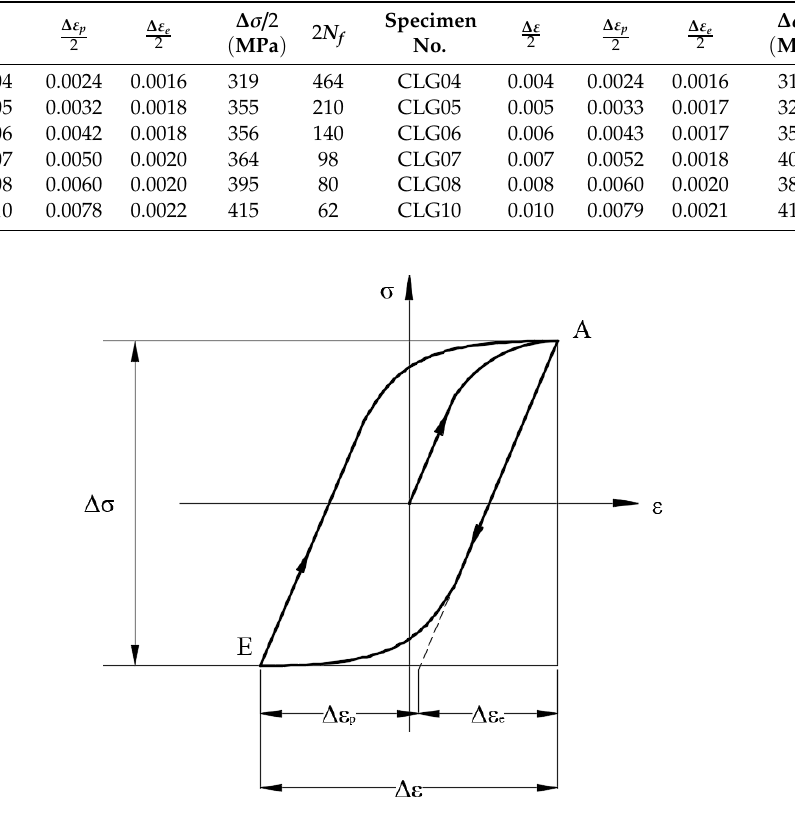
Figure 3. Cyclic stress–strain hysteresis curve.